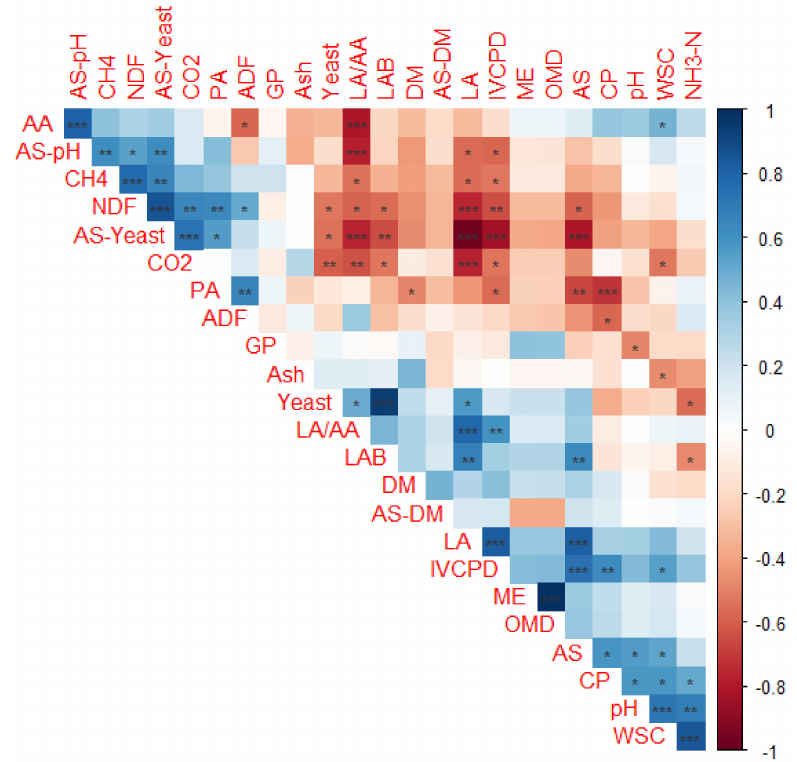
Figure 7. Pearson’s correlation coefficients for fermentation characteristics, microbial and chemical compositions, cell wall components, aerobic stability, gas production in vitro and methane values of corn silage. The blue and red squares indicate positive and negative correlations, respectively, and the empty cases refer to non-significant correlations. AA: acetic acid, AS-pH: pH after 7 days of aerobic exposure, CH 4 : methane, AS-Yeast: yeast count after 7 days of aerobic exposure, CO 2 :